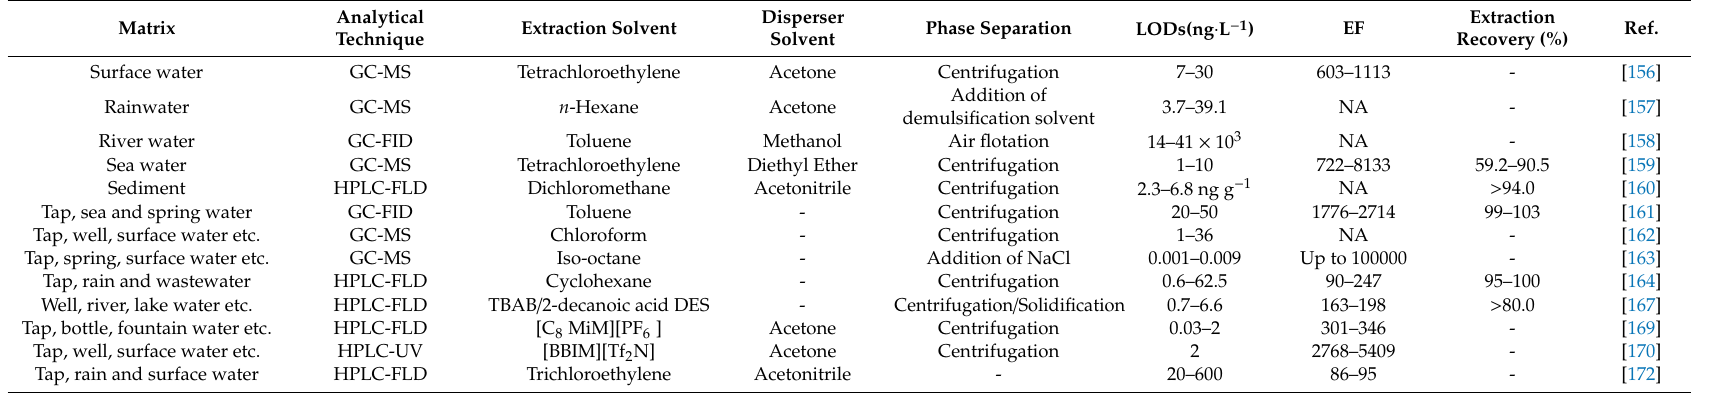
Table 2. Applications of dispersive liquid-liquid microextraction (DLLME) and ultrasound-assisted emulsification microextraction (USAEME) in the extraction of PAHs from water